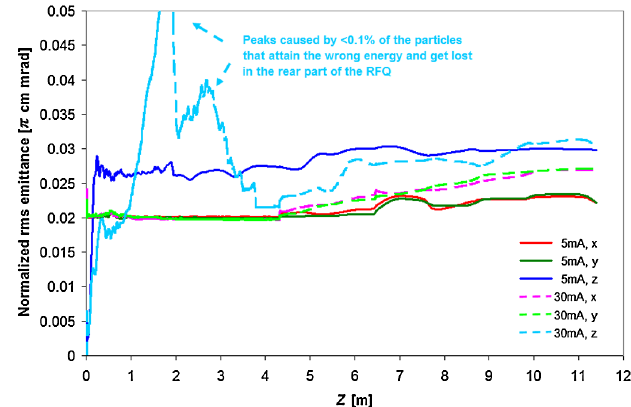
FIG. 11. (Color) 100% transverse beam envelopes along the injector (positive: x plane; negative: y plane). FIG. 12. (Color) End-to-end emittance